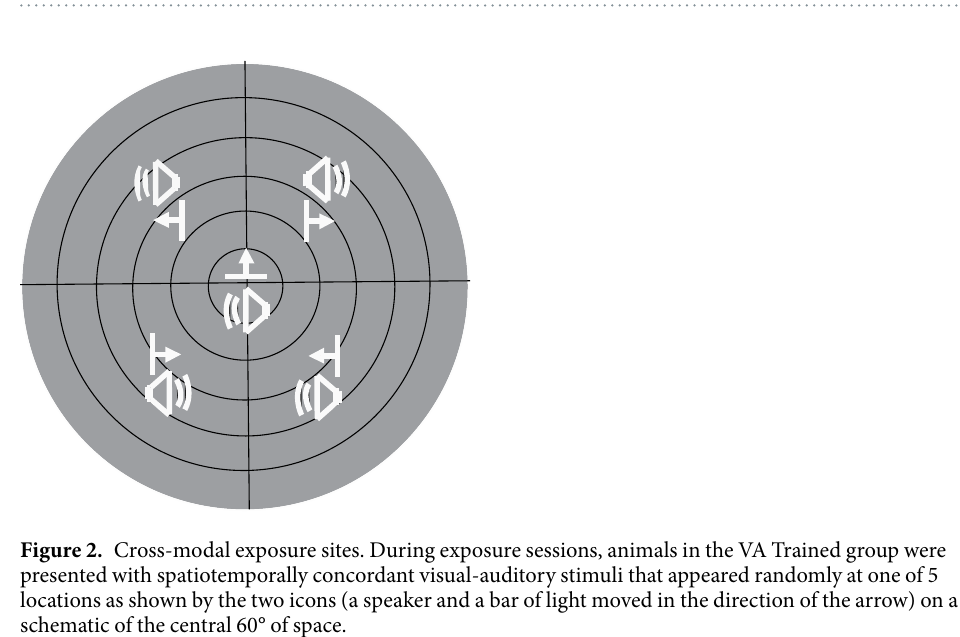
Figure 1. Experimental design. The Experimental timeline shows the periods in which noise-rearing (noise), normal housing (normal), and visual-auditory cross-modal exposure (VA Trained) took place.